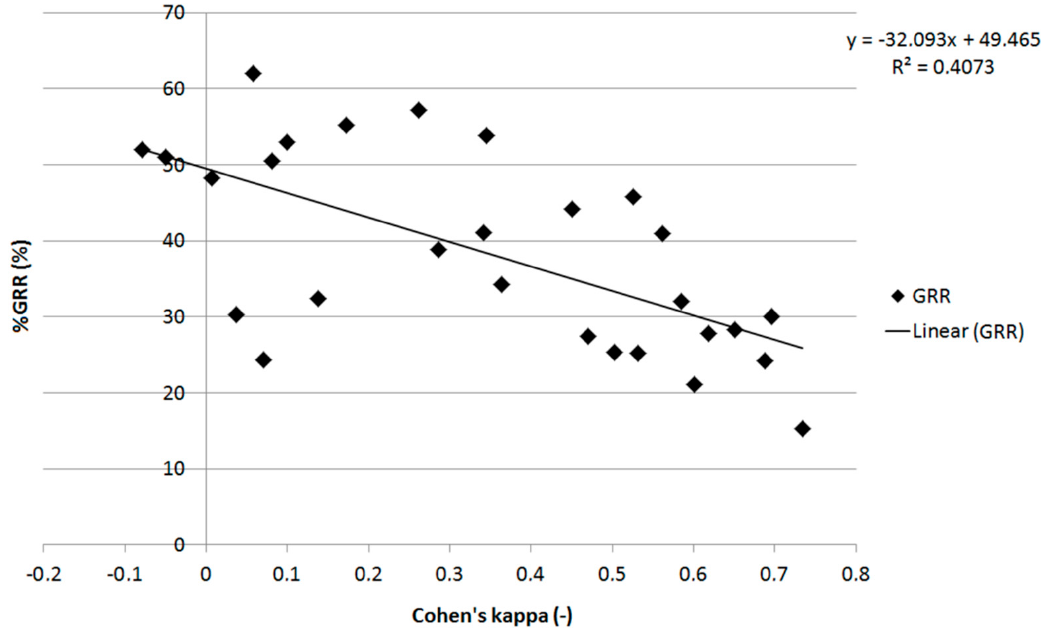
Figure 5. Relationship between Cohen’s kappa and %GRR.